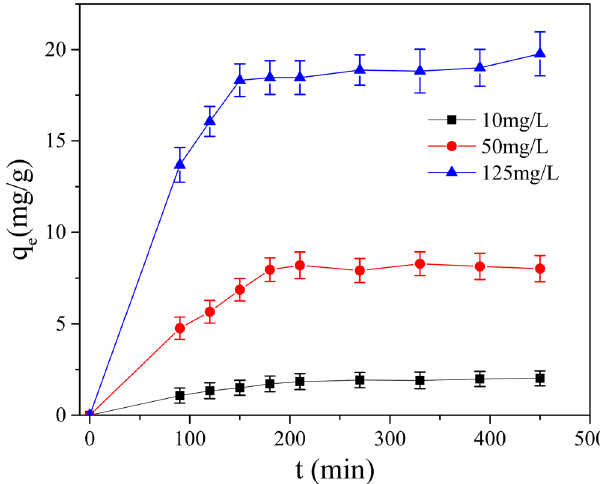
Figure 9. Effect of contact time on removal Mn(II) by GAD.